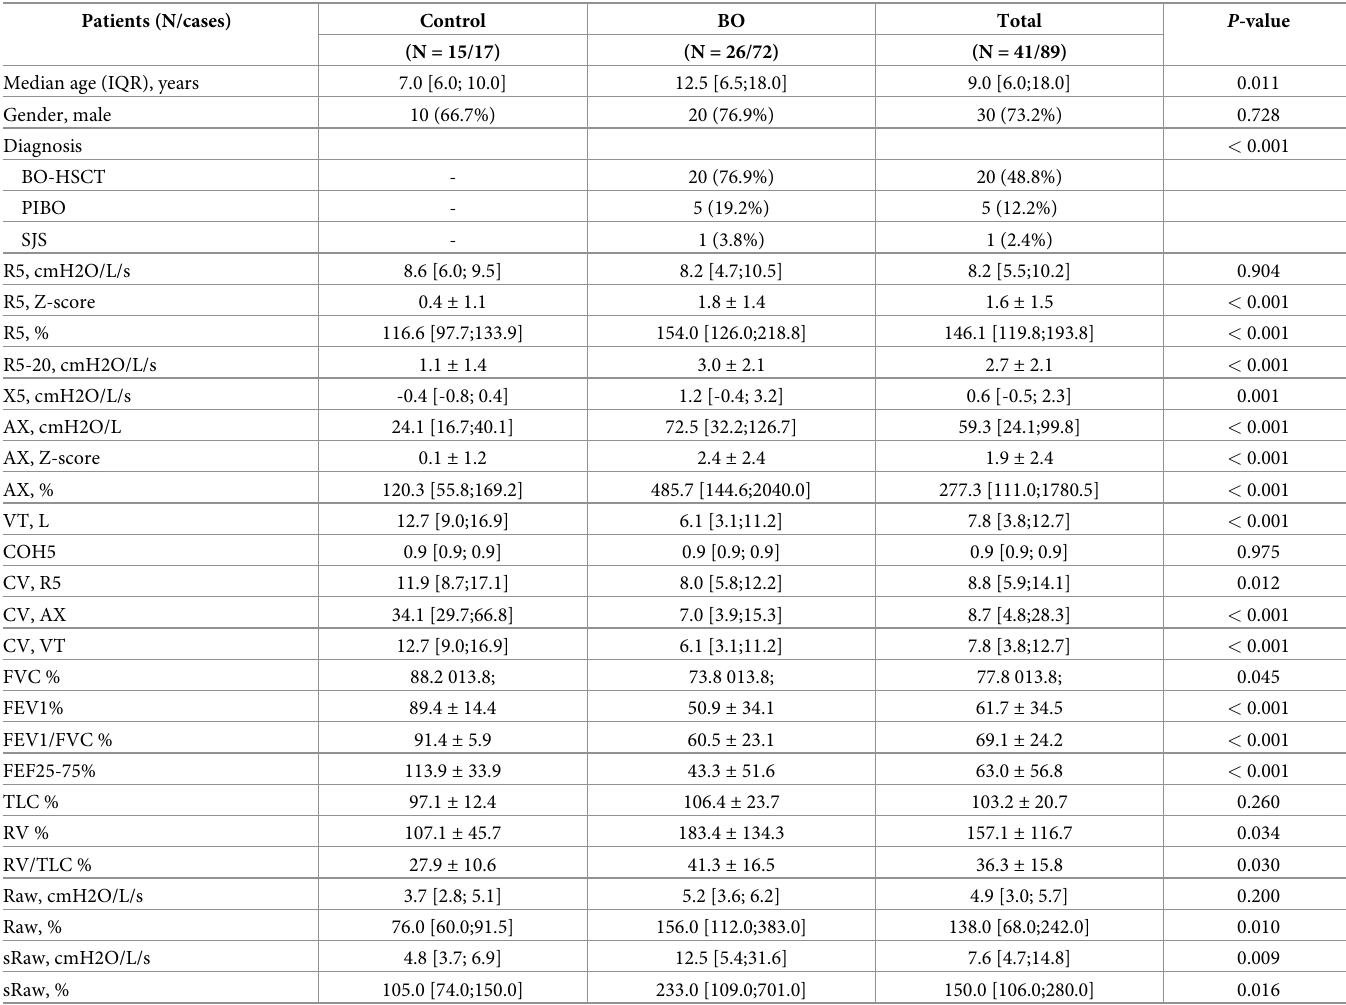
Table 1. Patient characteristics in all